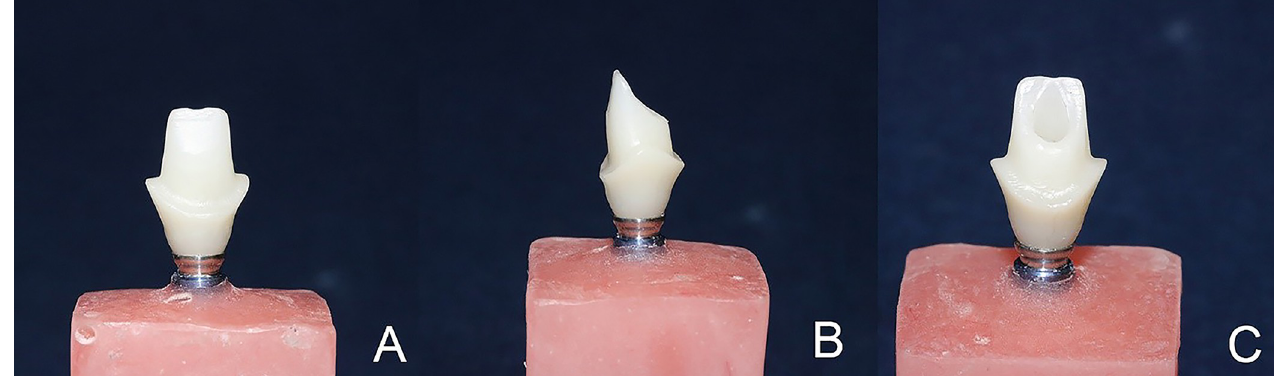
Fig 1. Milled customized zirconia abutment superstructure. A: buccal surface, B: proximal surface, C: lingual surface. The bonding surface of the titanium implant insert (ZrGEN; AnyOne; model: AAOIPR4525; Megagen, South Korea) was abraded with 50- μ m aluminum oxide particles at a 10-mm distance for 10 seconds (0.4 MPa). The inner surface of zirconia abutment superstructures was also subjected to airborne particle abrasion with 30- μ m silica-coated aluminum oxide (Rocatec Soft; 3M ESPE, USA).